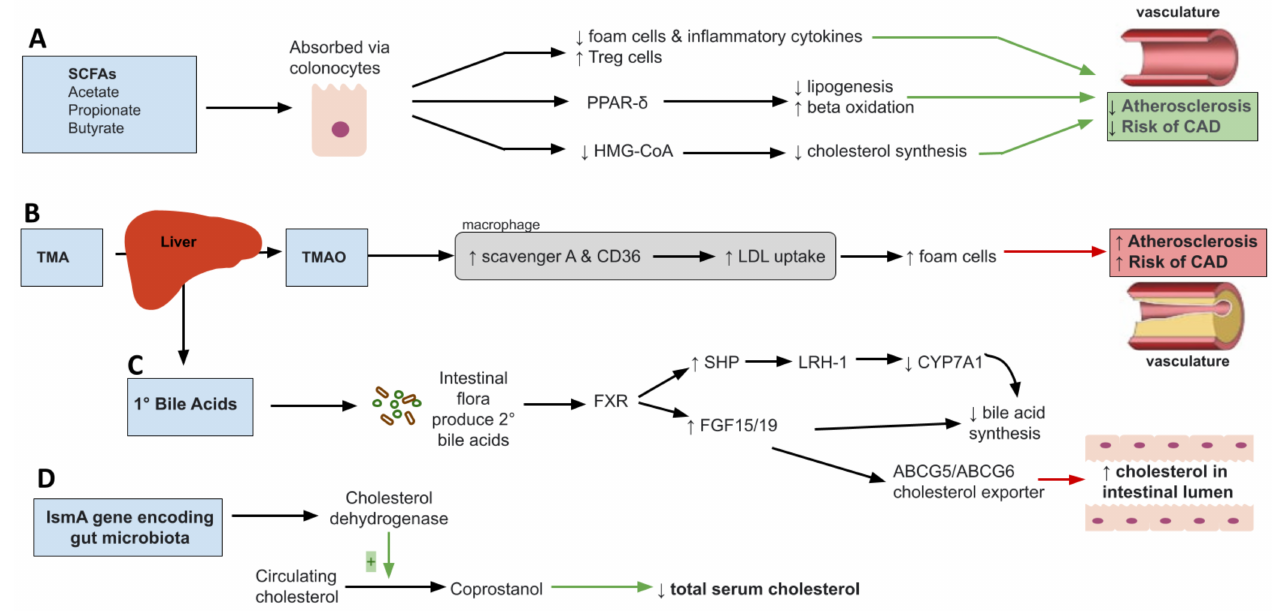
Figure 1. Role of Gut Microbiota Metabolites on Dyslipidemia and Atherosclerosis. ( A ) SCFAs are absorbed by colonocytes, leading to decrease foam cells, inflammatory cells, and decrease HMG- CoA thereby decreasing cholesterol synthesis. SCFAs increase T-regulatory cell activation and increase PPAR- δ activity, increasing beta-oxidation and decreasing lipogenesis. Increase SCFA production decreases atherosclerosis and risk of CAD. ( B ) Trimethylamine gets oxidized in the liver to form TMAO, which increases scavenger A and CD36 activity of macrophages and LDL uptake. This leads to formation of foam cells, contributing to increased atherosclerosis and CAD risk. ( C ) Primary bile acids synthesized by the liver are conjugated to secondary bile acids by gut microbiota. Secondary bile acids upregulate FXR leading to increase production of inhibitory nuclear receptor SHP. SHP interacts with living receptor homolog-1 to suppress transcription, interacts with CYP7A1 gene, decreasing synthesis of primary bile acid. FXR also induces FGF15 and FGF19 increasing ABCG5/ABCG6 cholesterol exporter, which helps translocate bile acids to the lumen. ( D ) IsmA encoding bacterial species contain enzymatic capability of converting circulating cholesterol to coprostanol which is excreted via feces, thereby decreasing serum cholesterol levels. Abbreviations: SCFA, short- chain fatty acids; Treg, T regulatory; CAD, coronary artery disease; PPAR, Peroxisome proliferator activated receptor; HMG-CoA, hydroxymethylglutarly Coenzyme A; TMA, Trimethylamine; TMAO, Trimethylamine N -Oxide; FXR, Farsenoid X receptor; SHP, small heterodimer partner; FGF, Fibroblast growth factor; LRH-1, living receptor homolog-1; ABCG; ATP-binding cassete gene; IsmA, intestinal sterol metabolism A; ↑ , upregulated; ↓ ,